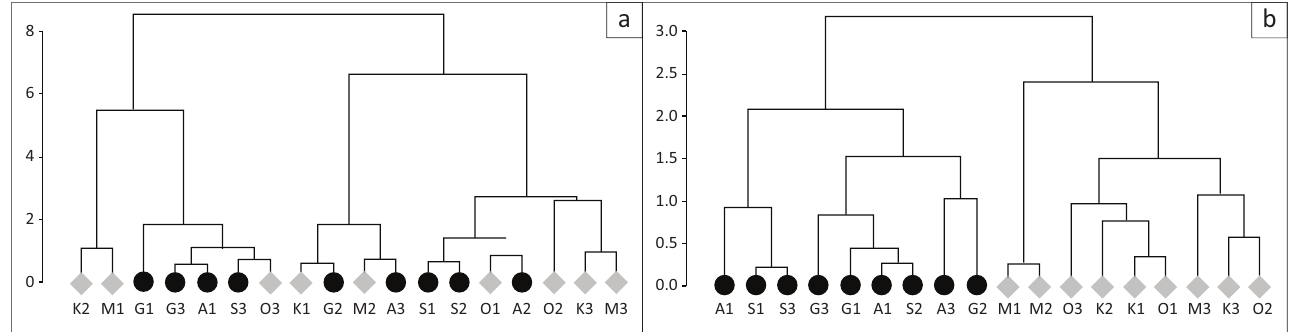
FIGURE 4: Result of the cluster analysis based on (a) feeding guild composition and (b) habitat preference category compositions. Groupings were based on Euclidean distances between transects. Protected areas are indicated with grey diamonds and communal rangelands are indicated with black circles.